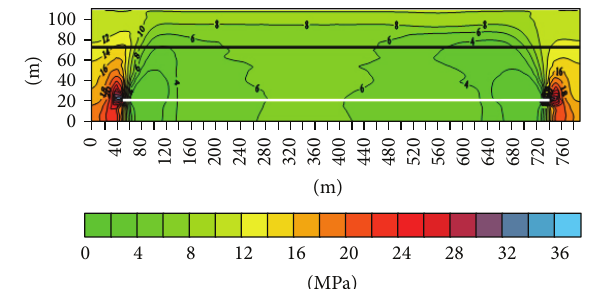
Figure 3: The surrounding rock stress profile along the working face advancing direction.